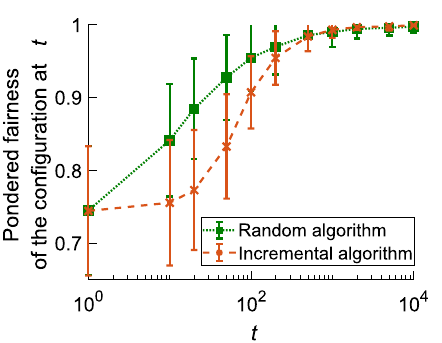
Figure 2. ( a ) Total reward, ( b ) fairness, and ( c ) modified Jain index I p for two users and two machines, using ψ 2 as the input state, as functions of the measurement basis tilt of each user. | �